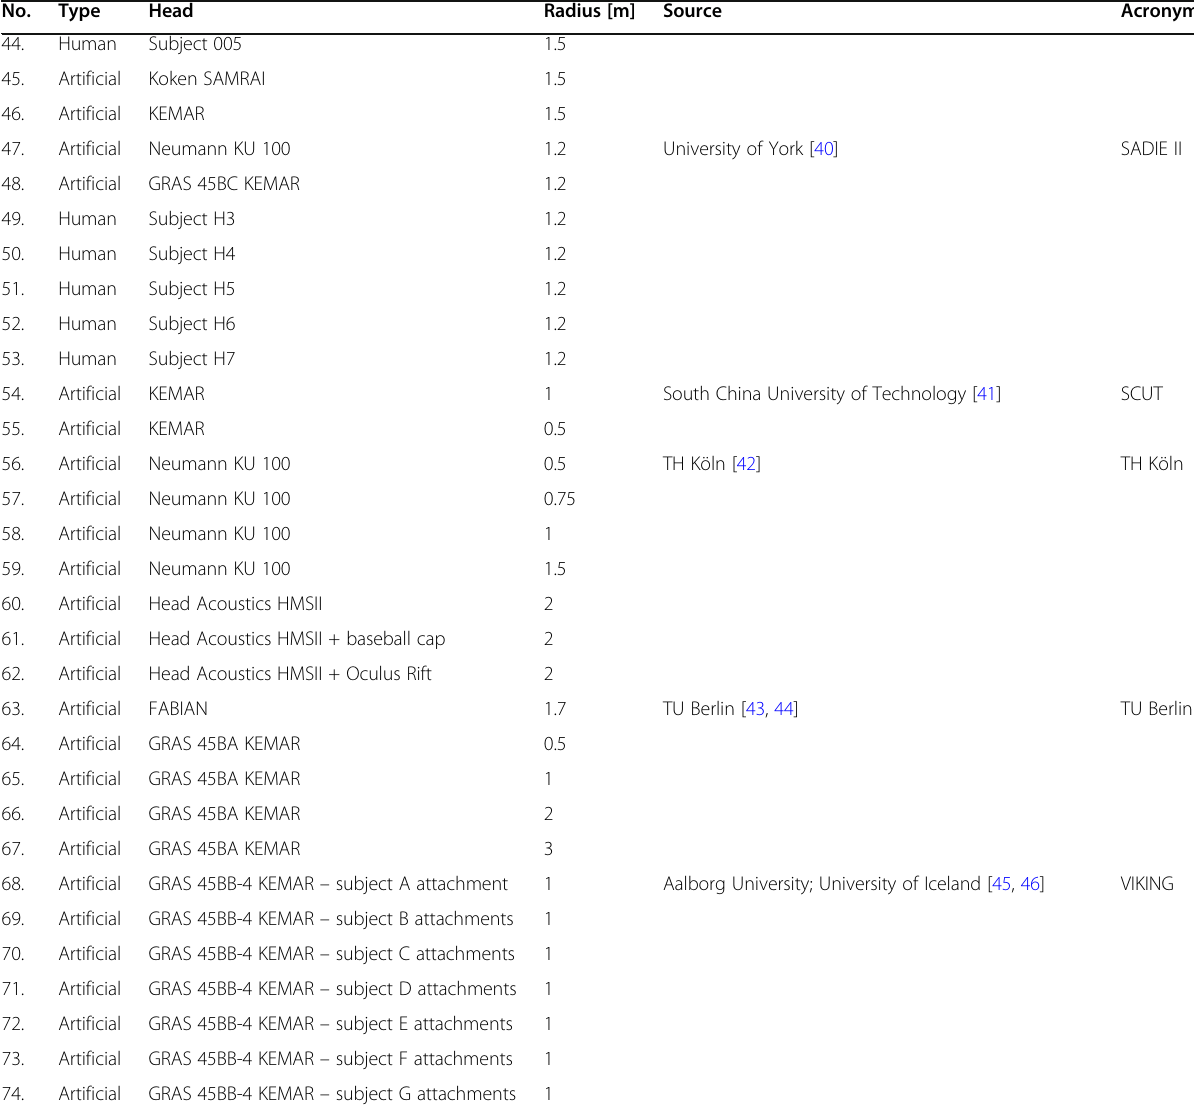
Table 3 List of HRTF sets used to synthesize binaural audio excerpts